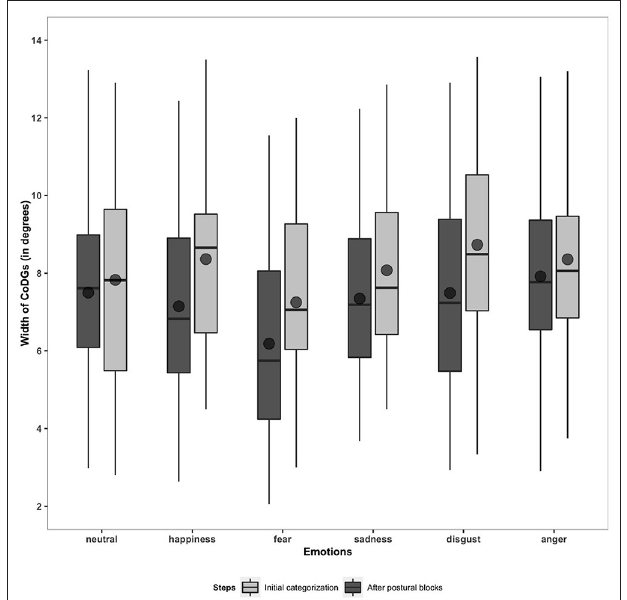
FIGURE 3 | Boxplots and means for CoDGs width (in degrees) based on steps (initial categorization, after postural blocks) and emotions (neutral, happiness, fear, sadness, disgust, and anger).